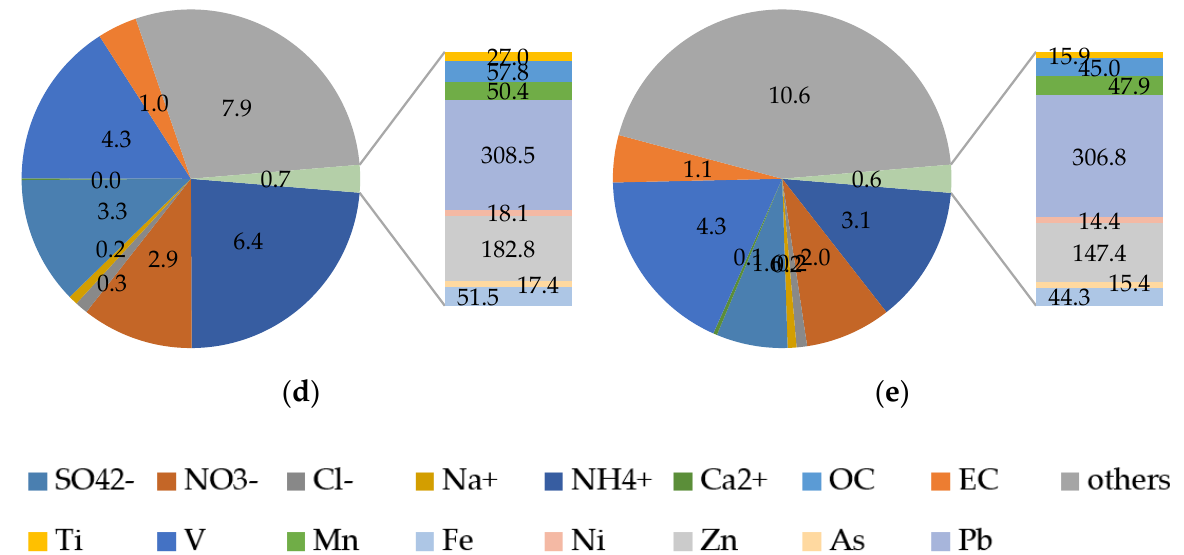
Figure 9. Annual mean concentrations of components in PM2.5 in Ulsan, obtained using the hourly data, for SCs. ( a ) Annual mean; ( b ) mean for winter months; ( c ) mean for spring months; ( d ) mean for summer months; ( e ) mean for fall months (unit: µg/m 3 for pie-chart, ng/m 3 for vertical chart) (see Table S5 for more detail).